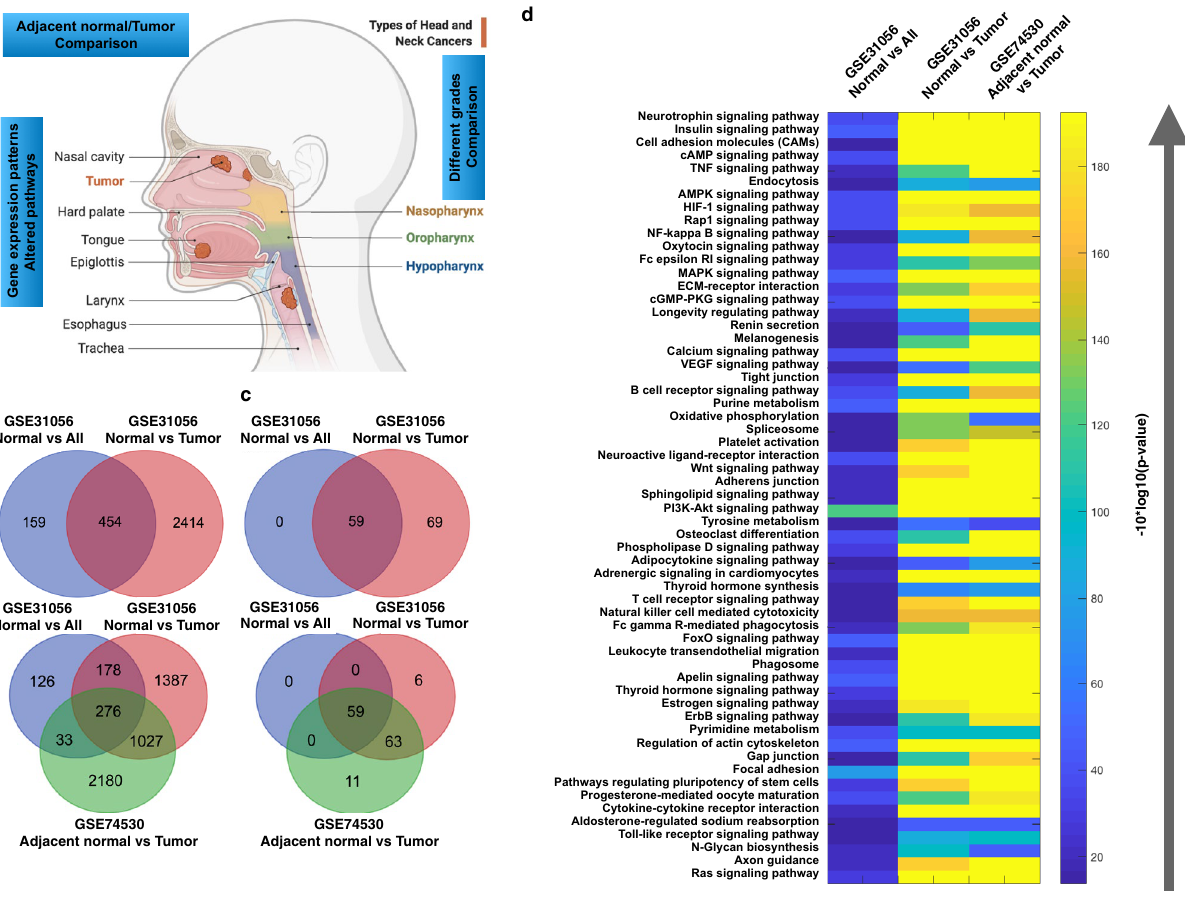
Figure 1. Differential gene expression profiling of different grades of oral cancer. ( a ) Venn diagram for differentially expressed genes, inferred, and enriched pathways; ( b ) Plot to show the overall number of DEGs, inferred, and enriched